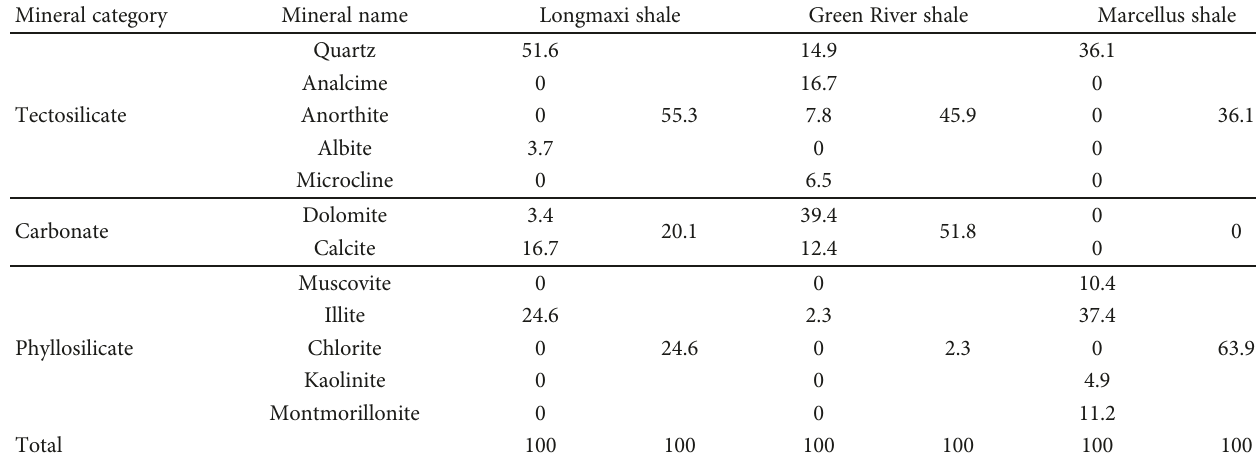
Table 1: Detailed mineralogical compositions (wt%) of each samples.